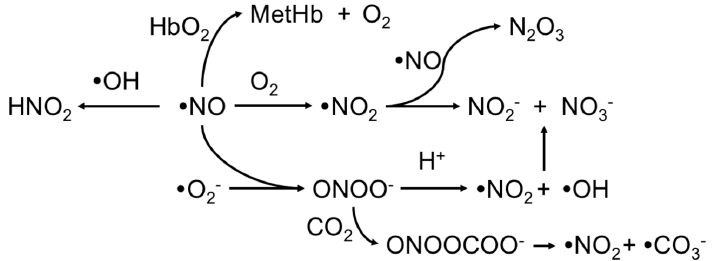
Figure 1. Nitric oxide (NO) has a very high reaction rate. Some of the pathways in the development and degradation of NO are shown